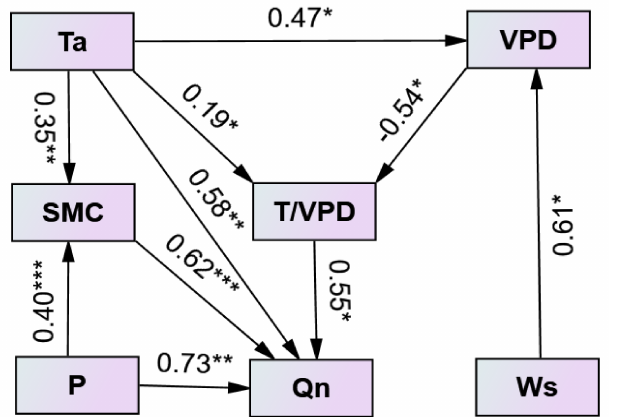
Figure 8. Direct and indirect effects of nighttime micro-hydrometeorological parameters, including air temperature (T a ), vapor pressure deficit (VPD), wind speed (W s ), canopy conductance (T/VPD), soil moisture content (SMC), and total nighttime precipitation (P) on interannual variation in nighttime sap flow (Q n ). Standardized path coefficients (i.e., − 1 to 1) are given for each arrow, where negative and positive effects are indicated by negative and positive values, respectively. Asterisks one, two and three (i.e., “*”, “**” and “***”) stand for significance levels < 0.05, 0.01 and 0.001, respectively. Data used were the growing season annual nighttime means for all parameters, but annual total for P from